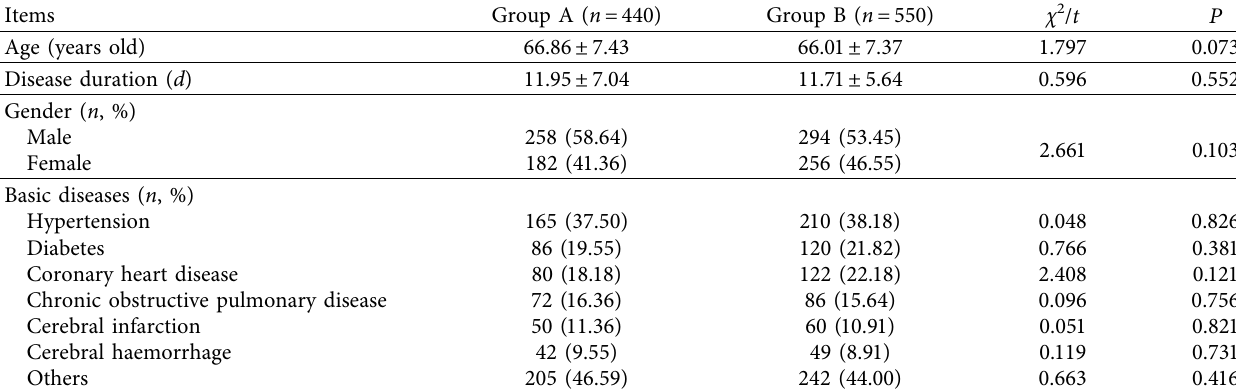
Table 1: General information for groups A and